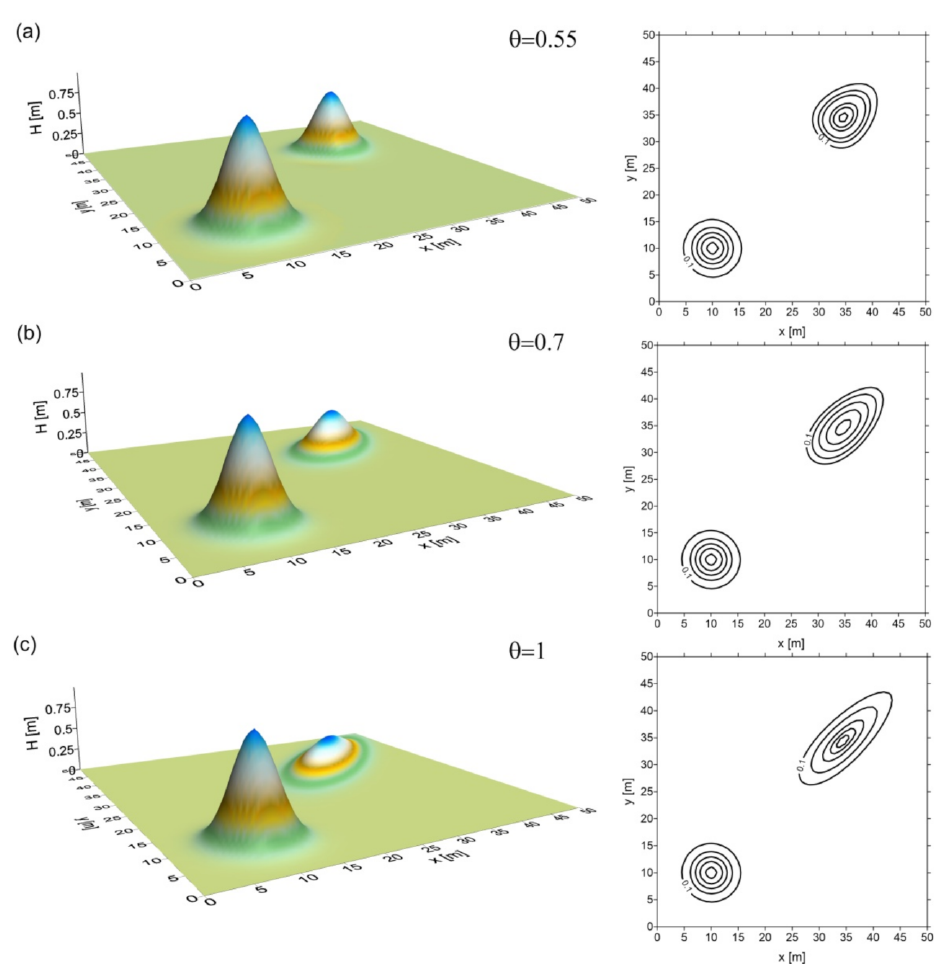
Figure 8. Solution obtained using the 6N mesh with α = 1/3 and C = 1 for various values of the parameter θ : ( a ) θ = 0.55; ( b ) θ = 0.7; ( c ) θ =